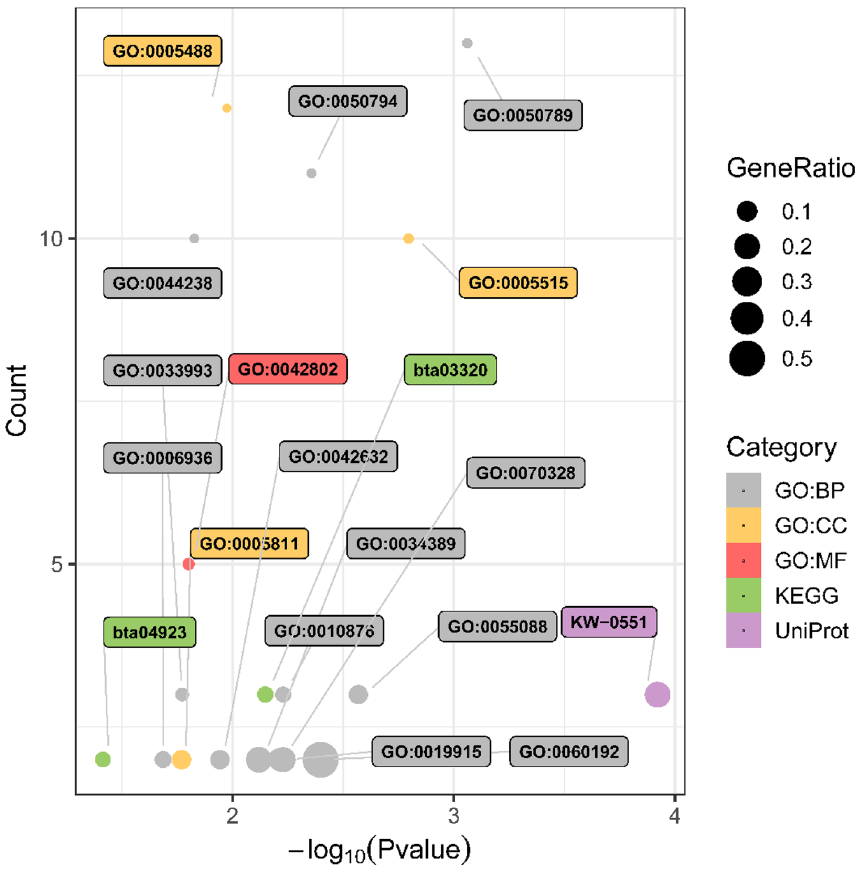
Figure 1. Significantly enriched GO, Pathway, and UniProt for intersection genes. P ≤